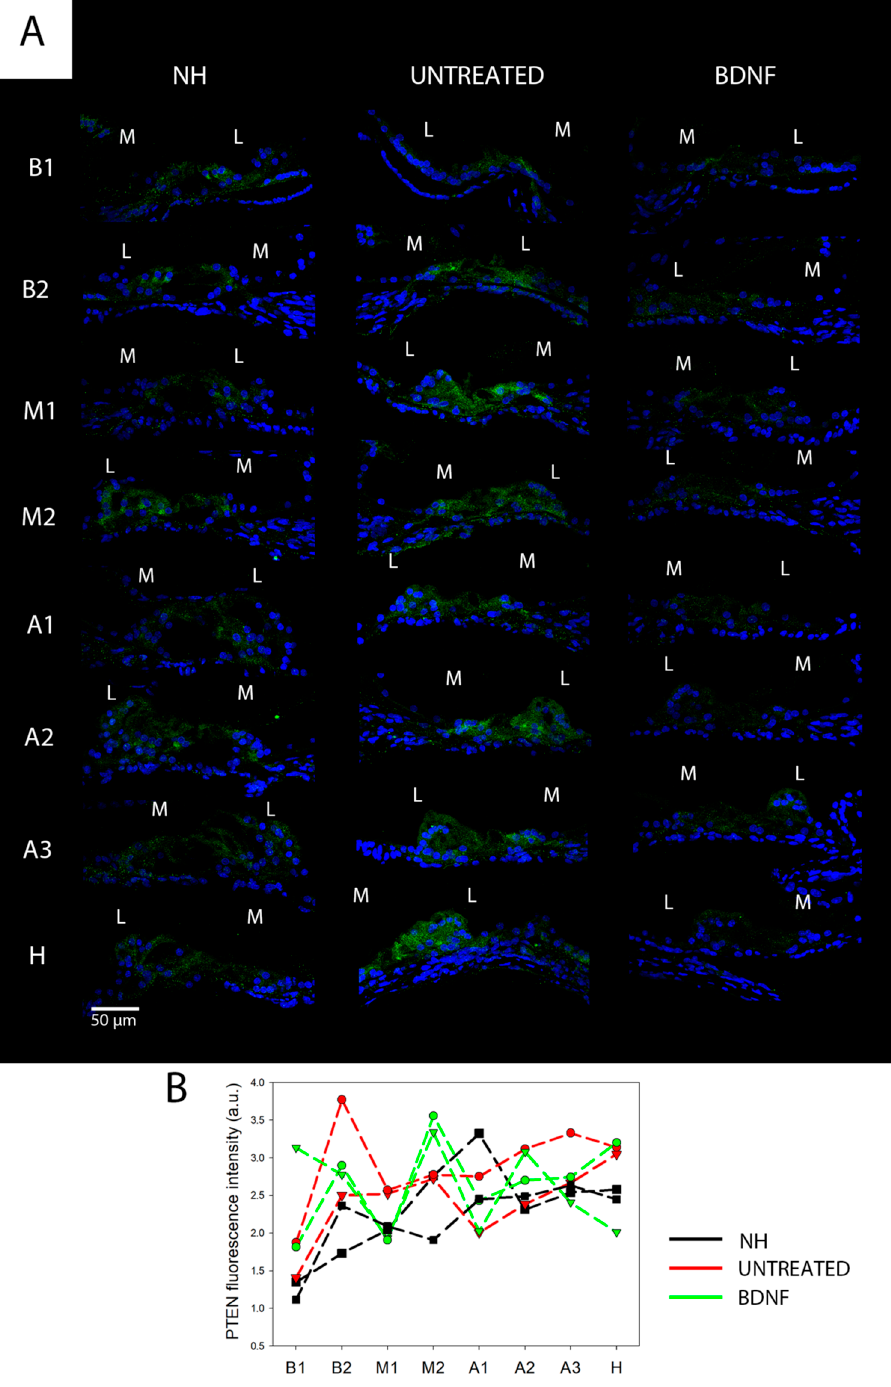
Figure 12. Immunolocalization and fluorescence intensity of PTEN. ( A ) Representative confocal images showing the organ of Corti immunolabelled with anti-PTEN (green) and counterstained with bisbenzimide nuclear dye (blue) of all experimental groups and for each cochlear location (from B1 to H). Scale bar: 50 µm. L: lateral, M: medial. ( B ) Fluorescence intensity analysis of PTEN immunostaining. The graph shows the signal intensity of each sample for all cochlear locations (black: NH, red: untreated, green: BDNF-treated). The same symbol was used to identify the BDNF-treated and untreated ears of individual animals.